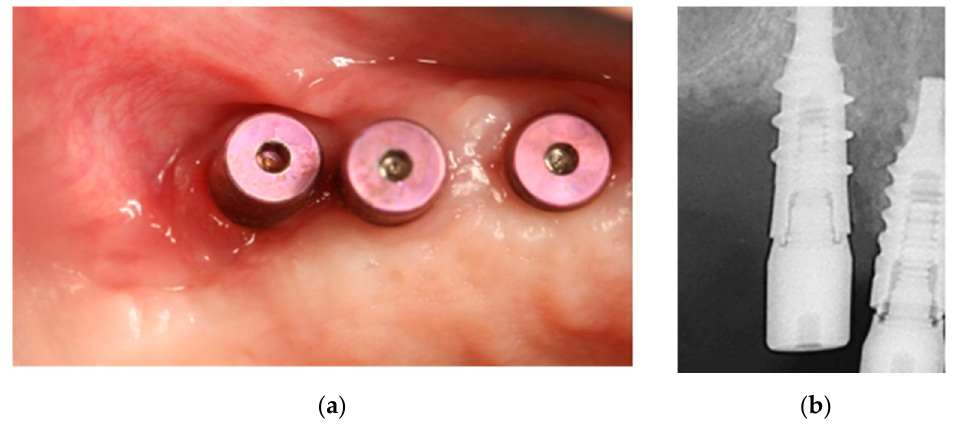
Figure 13. ( a ) Soft tissues with normal appearance at 12 months; ( b ) Radiographically stable bone tissue at 12 months.